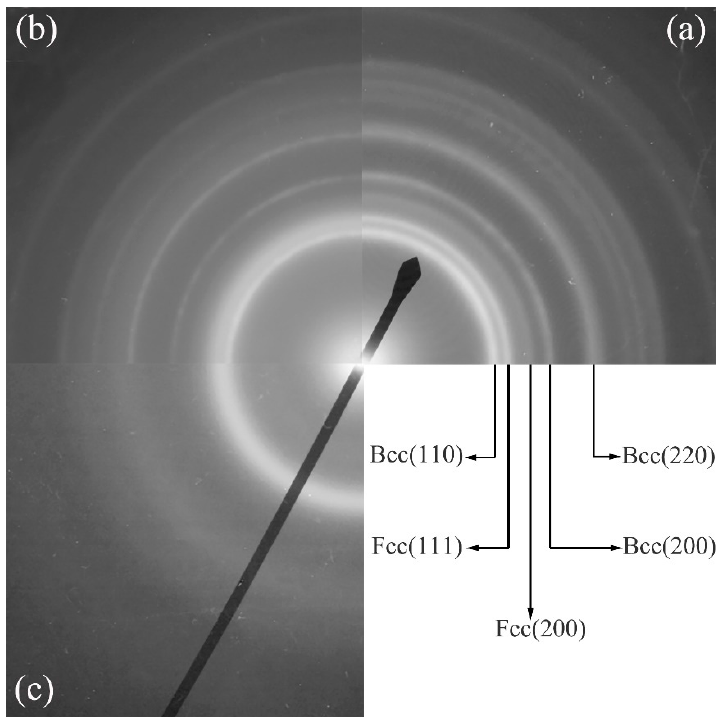
Figure 7. The SAD patterns of resultant phases formed in the Ni 51 Nb 19 Mo 30 nano-multiple-metal-layers [71] ( a ) at as-deposited state, after being irradiated to a dose of ( b ) 1 × 10 15 Xe + /cm 2 and ( c ) 5 × 10 15 Xe + /cm 2 . Table 5. Phase transformation for the Ni-Nb-Mo multiply layers upon Xe + beam mixing to different doses [71]. (A: amorphous phase; Bcc: bcc crystalline phase; Fcc: fcc crystalline phase).